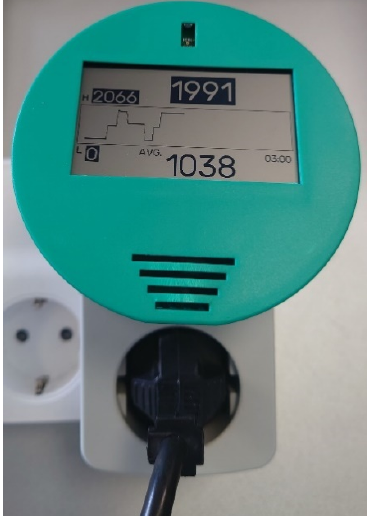
Table 3. Appliances used for experiments. Figure 15. Smart-meter module. Figure 15. Smart-meter module.